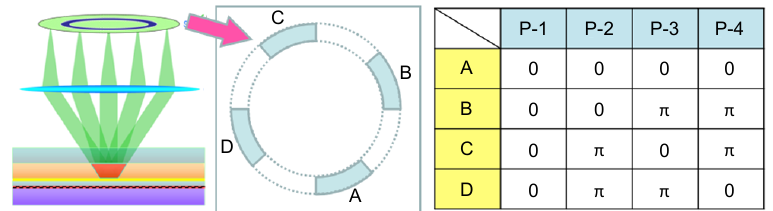
Fig. 7 | Phase modulation of reference pattern for data page